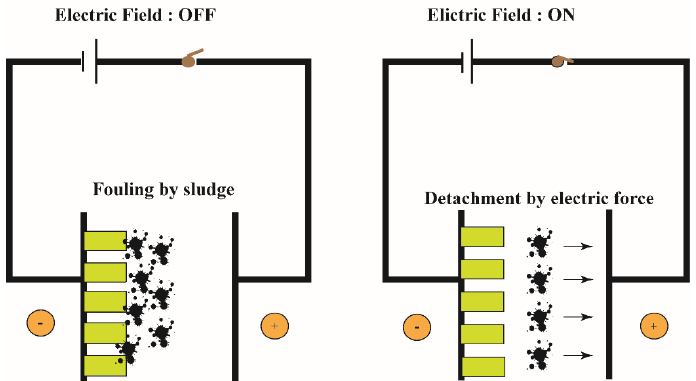
Figure 2. Effect of additional electric field on MBR membrane fouling. 331 Figure 2. E ff ect of additional electric field on MBR membrane